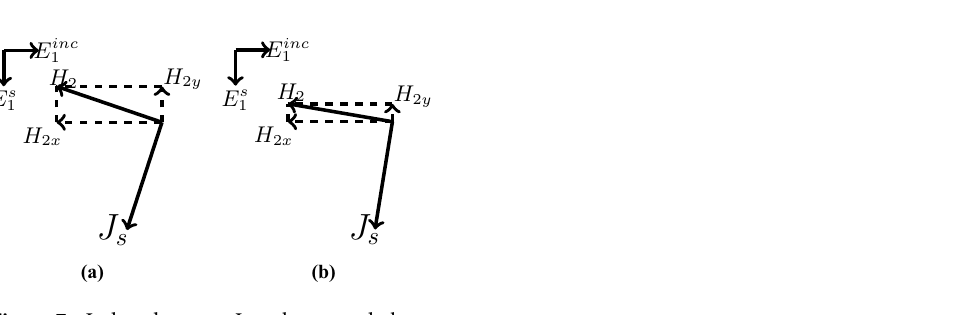
Figure 7. Induced current J on the ground plane.